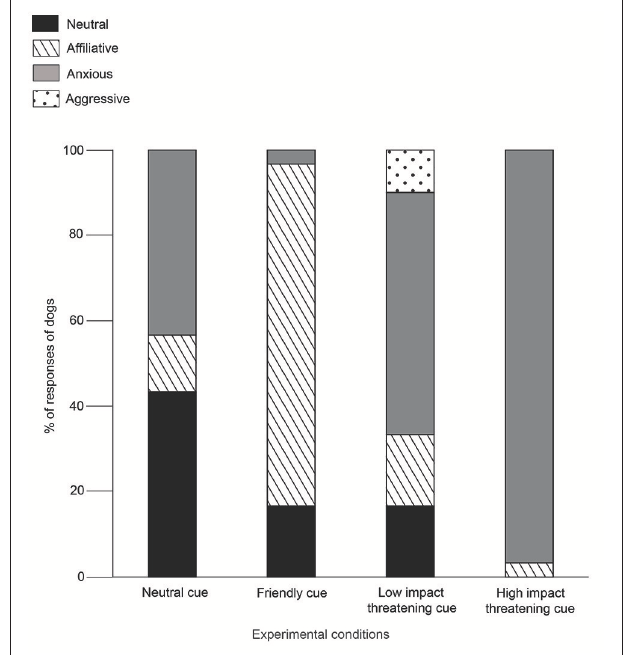
FIGURE 4 | Demeanours (Holistic). Stacked bar graph showing the demeanours of dogs in SCP of NC, FC, LIT, and HIT conditions. for the analysis of feeding time ( N = 59). We found a significant difference in feeding time (Kruskal—Wallis test, χ 2 = 8.366, df = 2, p = 0.015, see Figure S5 ). Post-hoc pairwise